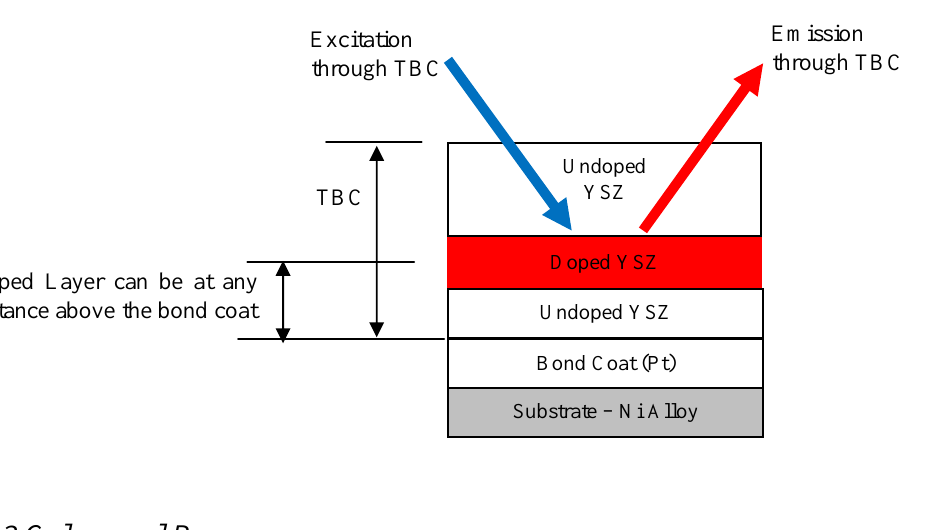
Figure 68. Phosphor thermometry at different distances though a